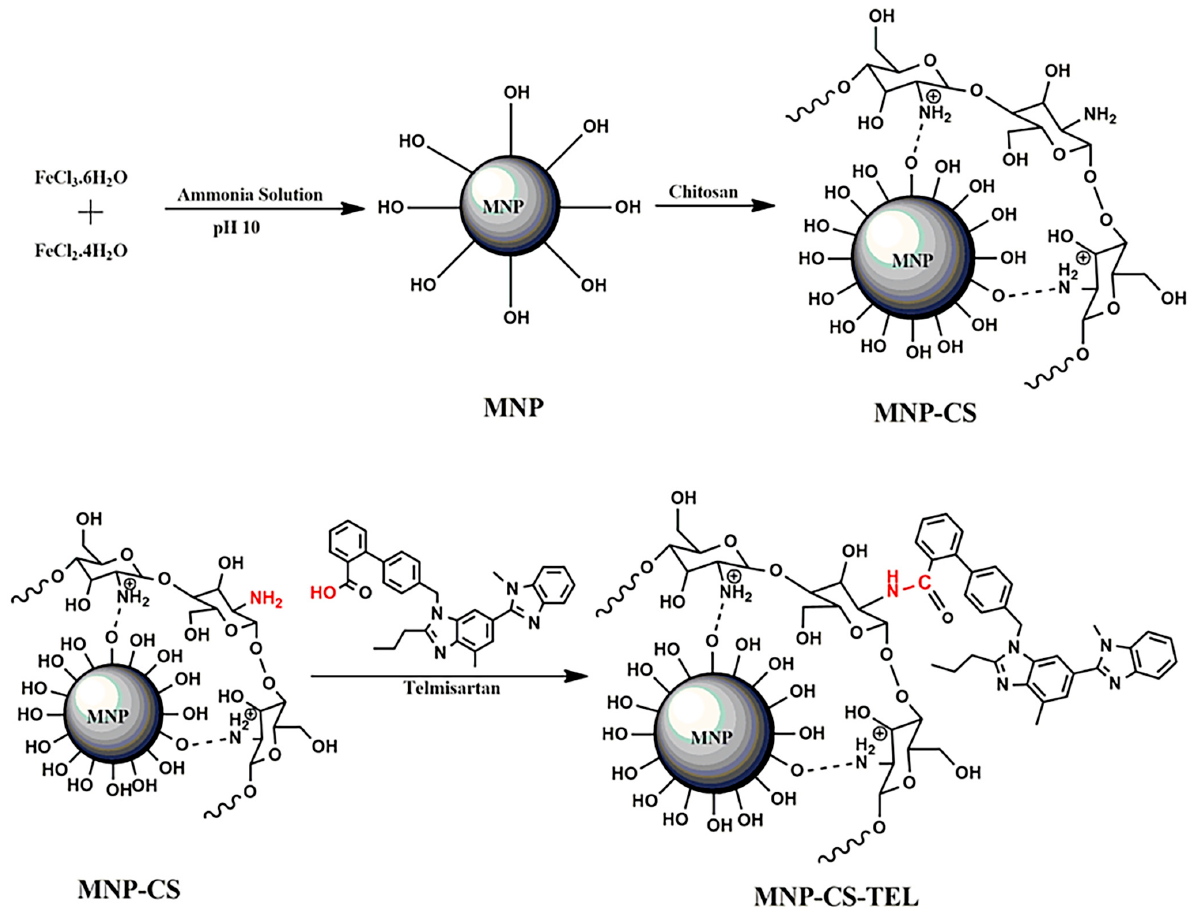
Figure 9. Synthesis of drug-loaded, chitosan-coated magnetite NPs. Reprinted from ref. [366], with permission from Elsevier, 2021.